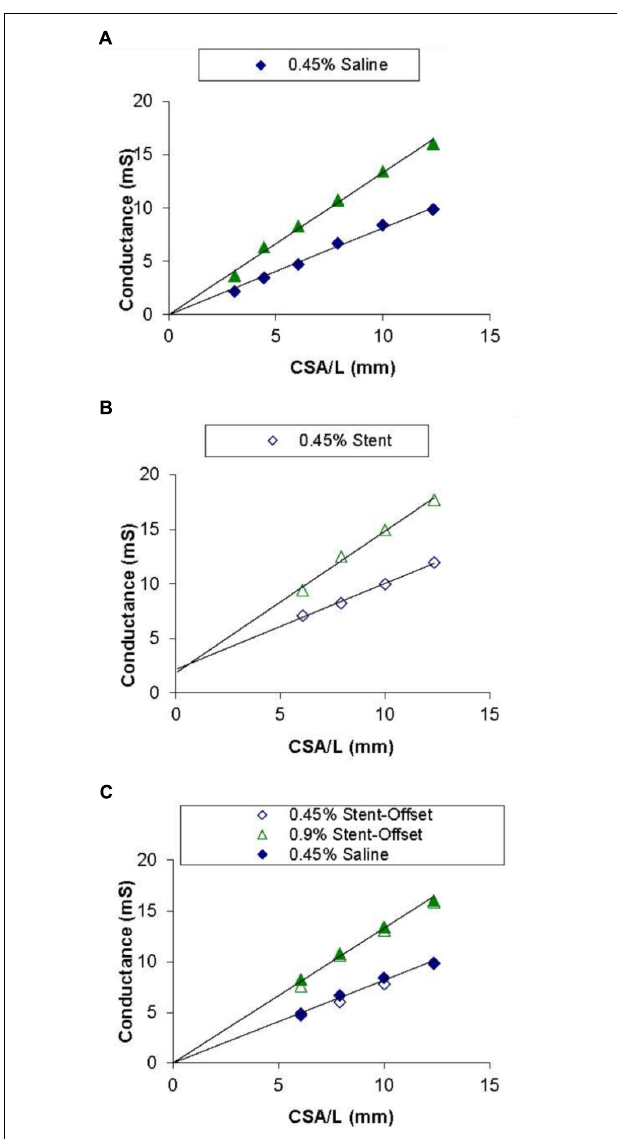
FIGURE 3 | Saline and stent calibrations of 0.45 and 0.9% NaCl solutions. Graph (A) shows conductance values for each corresponding CSA in acrylic tubes filled with saline only. Graph (B) shows the values with the stent embedded in each of the tubes. Graph (C) shows both saline only and stent values with normalized offsets. Lines of best fit are shown in Graphs (A) and (B) .